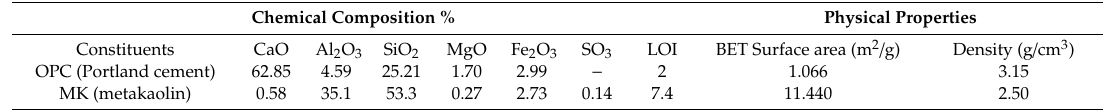
Table 1. Chemical composition of materials.